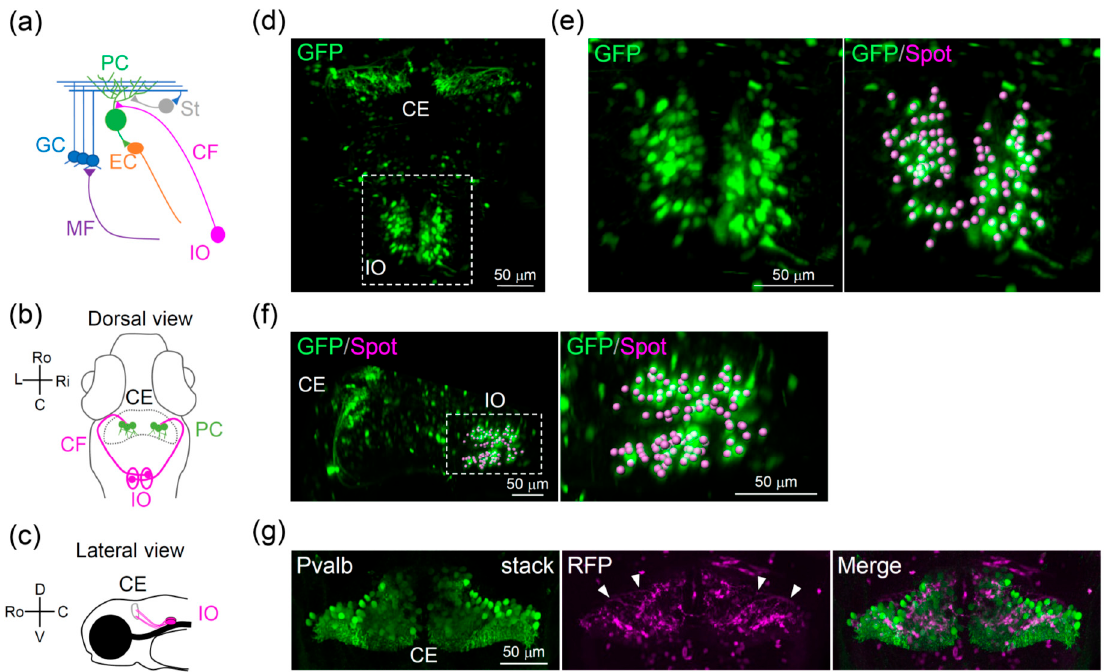
Figure 1. Cerebellar circuits in zebrafish: ( a ) Schematic diagram of the cerebellar circuits in zebrafish. ( b , c ) Schematic diagram of the olivocerebellar circuits: ( b ) Dorsal view and ( c ) lateral view. ( d – f ) Distribution of inferior olive neurons in Tg ( hspGFFDMC28C ; UAS : GFP) zebrafish at 7 days post-fertilization (dpf): ( d , e ) Dorsal view, with a high-magnification image shown in ( e ), where spots indicate the position of the soma of inferior olive neurons. ( f ) Dorsolateral view, with a high-magnification image of the inferior olive shown in the right panel. ( g ) Dorsal view of the cerebellum of Tg ( hspGFFDMC28C ; UAS : RFP) larva stained with Parvalbumin 7 (Pvalb) at 6 dpf (confocal z-stack images). Arrowheads indicate CFs. CE, cerebellum; CF, climbing fiber; EC, eurydendroid cell; GC, granule cell; IO, inferior olive; MF, mossy fiber; PC, Purkinje cell; St, stellate cell; Ro, rostral; C, cordal; L, left; Ri, right; D, dorsal; V, ventral.